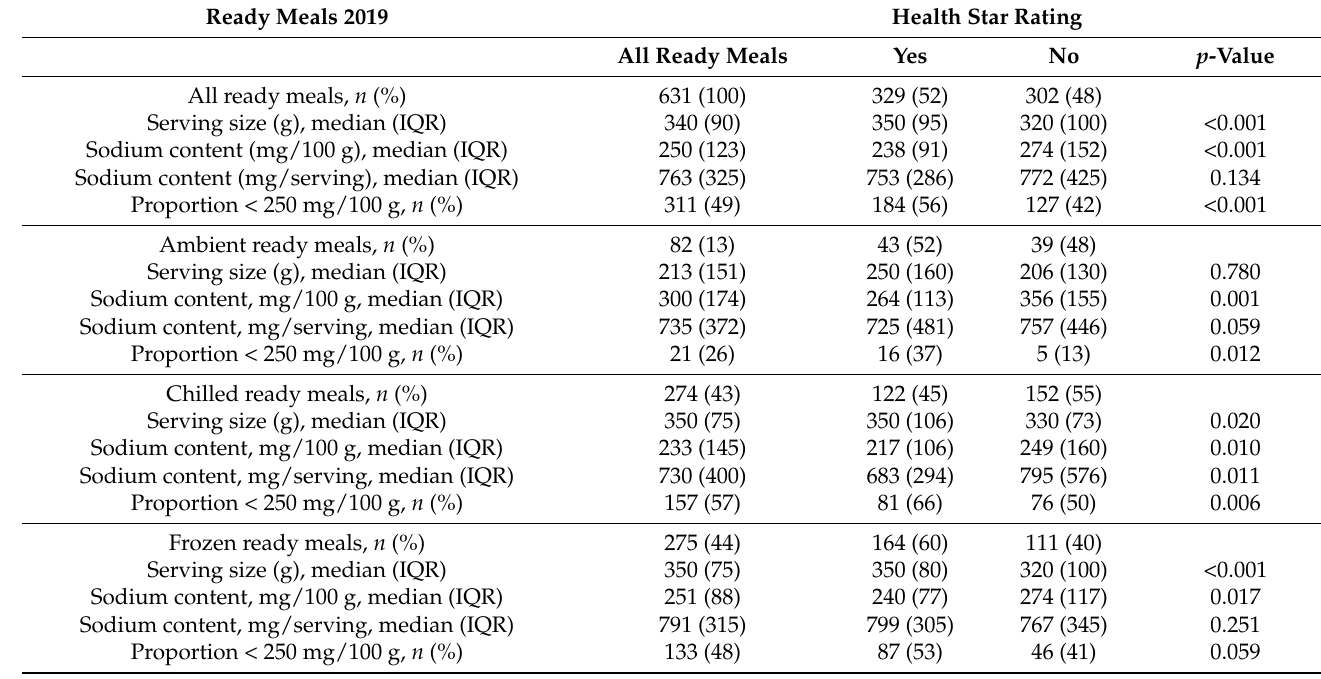
Table 1. Comparison of median (IQR) sodium content of products with and without a front-of-pack Health Star Rating, and proportion meeting the Healthy Food Partnership sodium reduction target (<250 mg/100